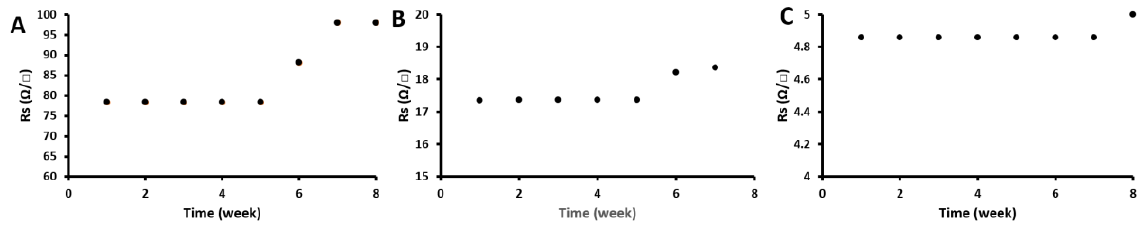
Figure 7. Electrical stability of the nanocomposite over a period of eight weeks at concentrations of ( A ) 9.21 wt%; ( B ) 21. 94 wt%; and ( C ) 50.46 wt%.